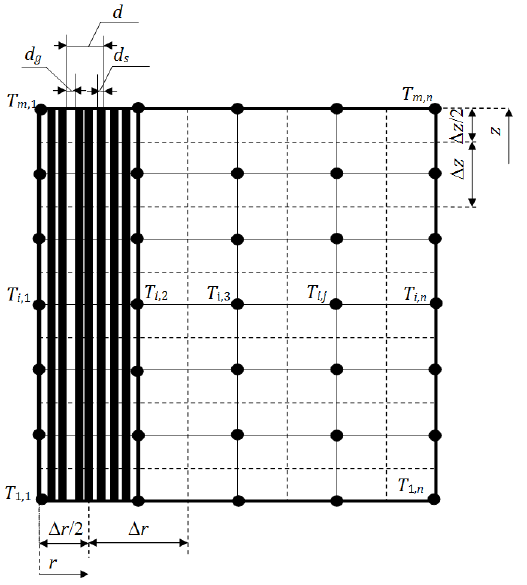
Figure 7. Gaps between the